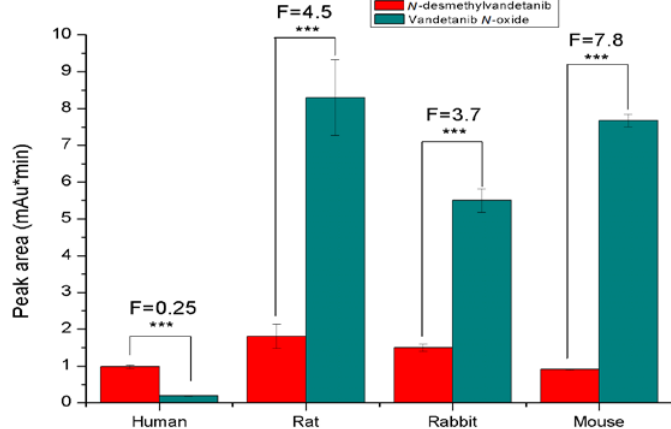
Figure 4. Oxidation of vandetanib by human, rat, rabbit and mouse hepatic microsomes. Values represent mean ± SD of three independent in vitro incubations ( n = 3). F, fold difference between formation of N -desmethylvandetanib and vandetanib- N -oxide. *** p < 0.001 significant differences between formation of N -desmethylvandetanib and vandetanib- N -oxide (ANOVA with post-hoc Tukey honestly significant difference (HSD) Test).